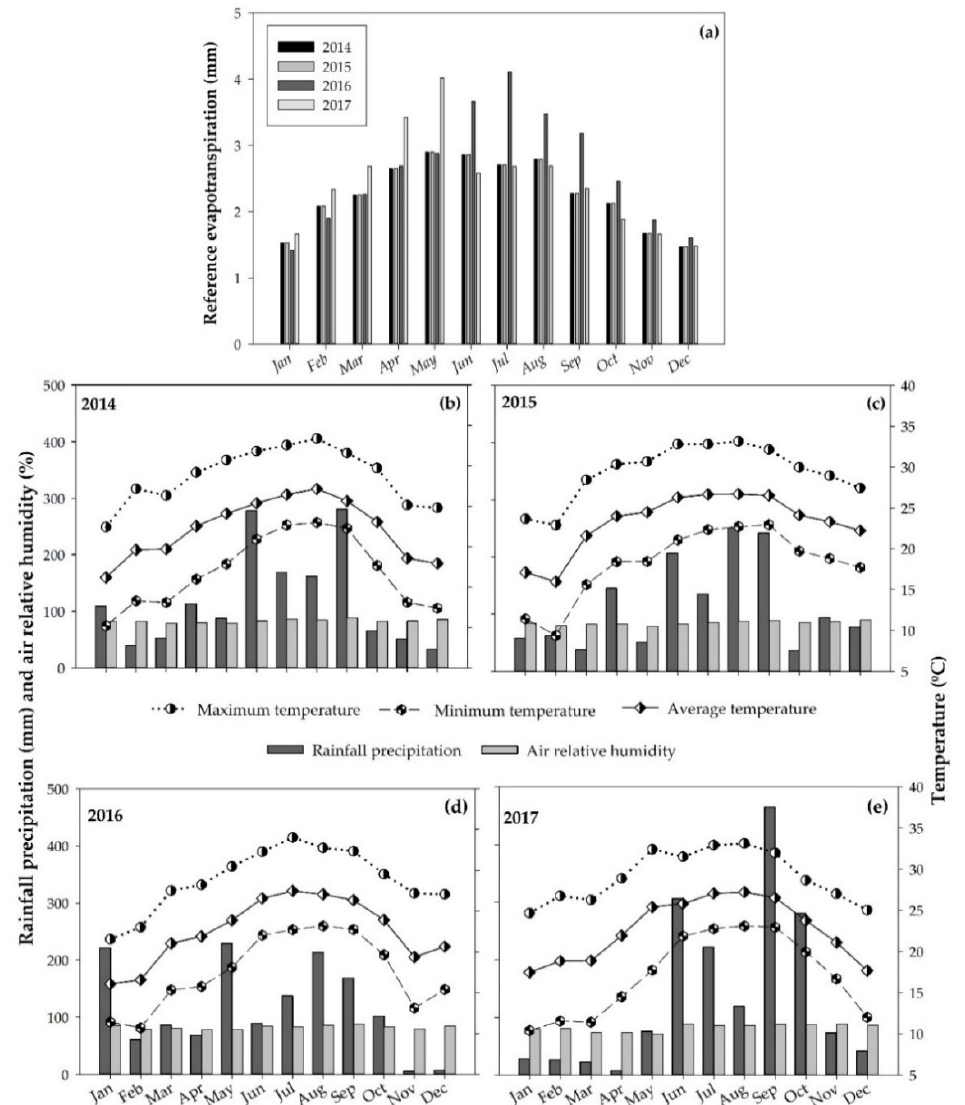
Figure 1. Monthly reference evapotranspiration (ET 0 ) ( a ), maximum, minimum, and average air temperatures at 2 m above the soil surface, rainfall precipitation and air relative humidity in 2014 ( b ), 2015 ( c ), 2016 ( d ), and 2017 ( e ). Data were collected from on-site weather stations managed by the Florida Automated Weather Network (FAWN).